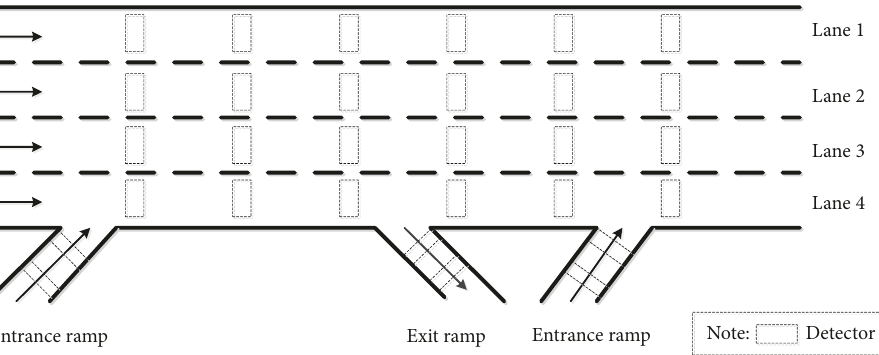
Figure 4: Data collection site and detector layout in one direction.